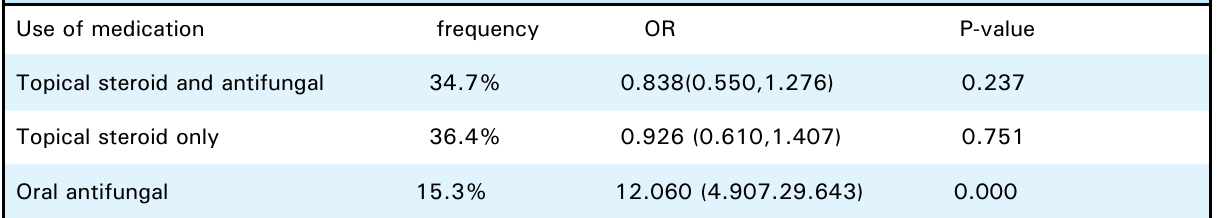
Table 3. relationship between patient’s use of drugs and consultation with dermatologist. Use of